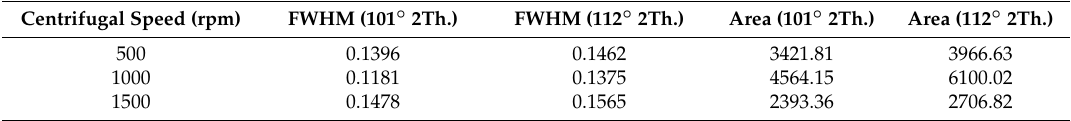
Figure 6. XRD patterns of NH 4 ReO 4 crystals at different centrifugal speeds: (a) 1000 rpm, (b) 500 rpm, (c) 1500 rpm. Table 4. XRD information of NH 4 ReO 4 crystals at different centrifugal speeds.